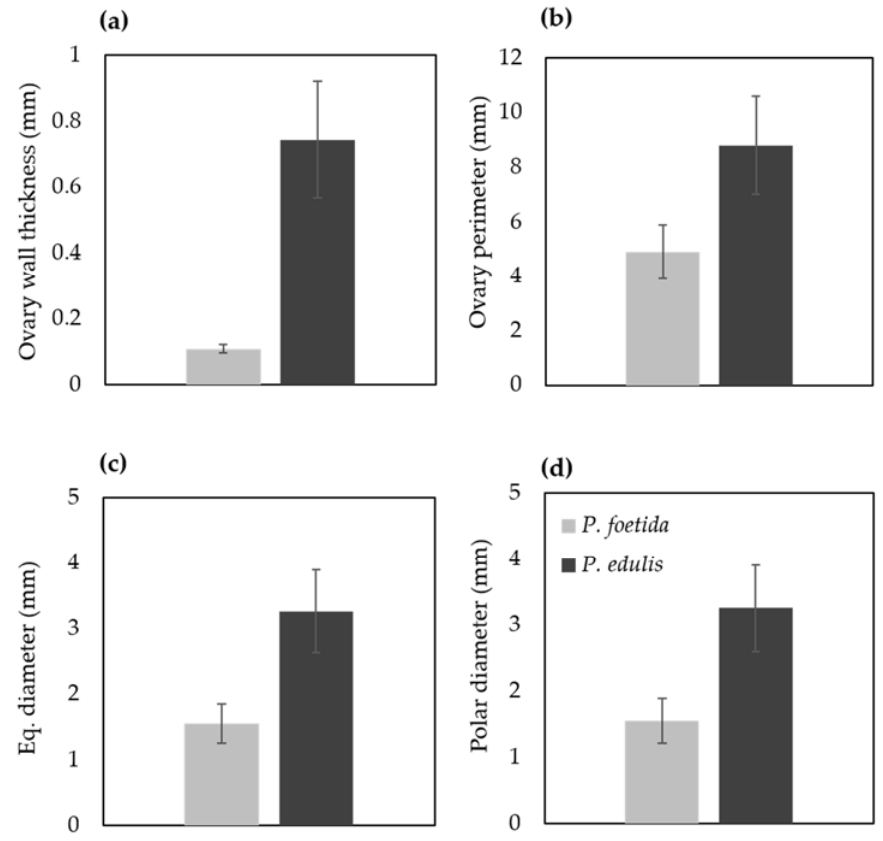
Figure 6. Micromorphological differences in the ovary of P. foetida (wild) and P. edulis (cultivated) species of Passiflora . ( a ) Ovary wall thickness, ( b ) perimeter, ( c ) Equatorial diameter and ( d ) Polar diameter. Data are mean ± SE ( n = 6 ).